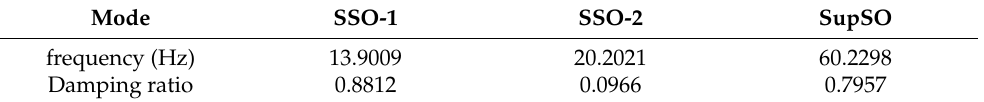
Table 2. Frequency and damping ratio corresponding to oscillation modes.